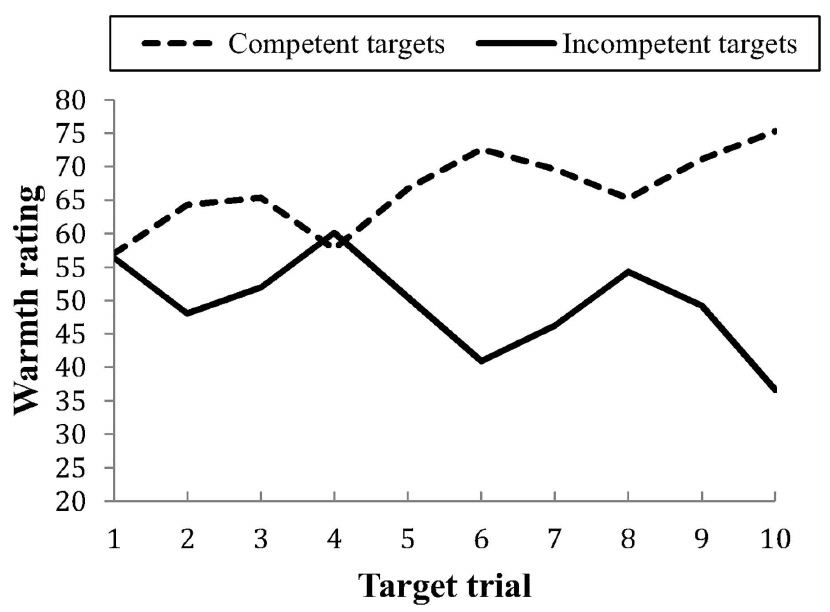
Fig 3. Competence ratings across the 10 trials for mainly competent and mainly incompetent targets.